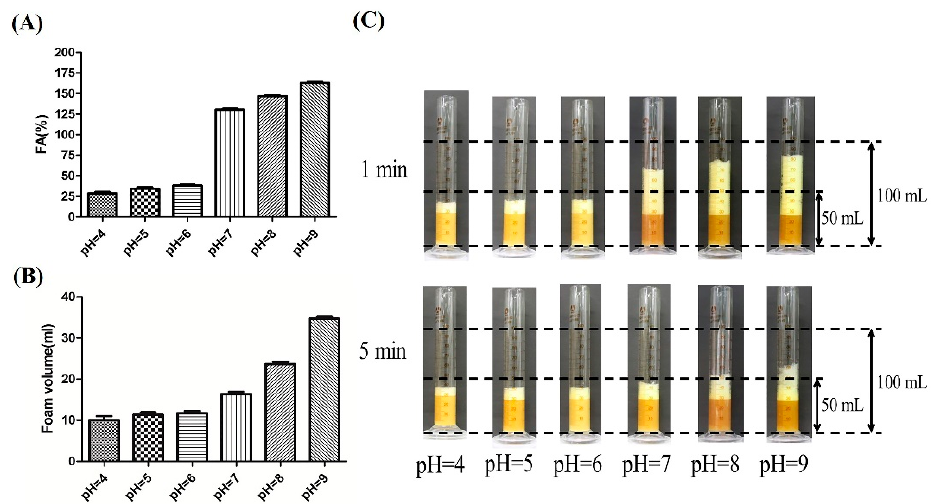
Figure 1. Evaluation of foaming properties of rhamnolipid fermentation broths at pH 4–8. ( A ) The foaming ability evaluation of rhamnolipid fermentation broths; ( B ) the foam volume of fermentation broths of rhamnolipids at 5 min; ( C ) the visual foam volume image of rhamnolipid fermentation broths after being stored at 1 and 5 min. The black dashed lines of the same height in ( C ) represent the same volume of the graduated cylinder.